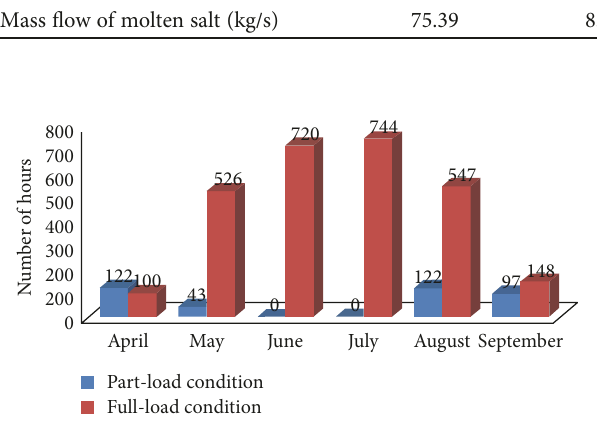
Figure 18: The received thermal energy for the Rankine cycle by both the solar fi eld and storage system.